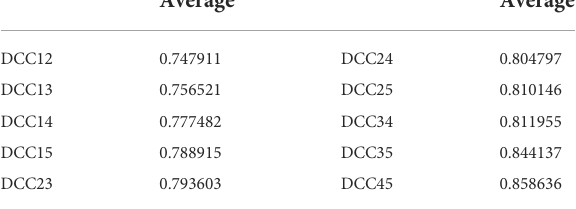
TABLE 3 The average DCC of different